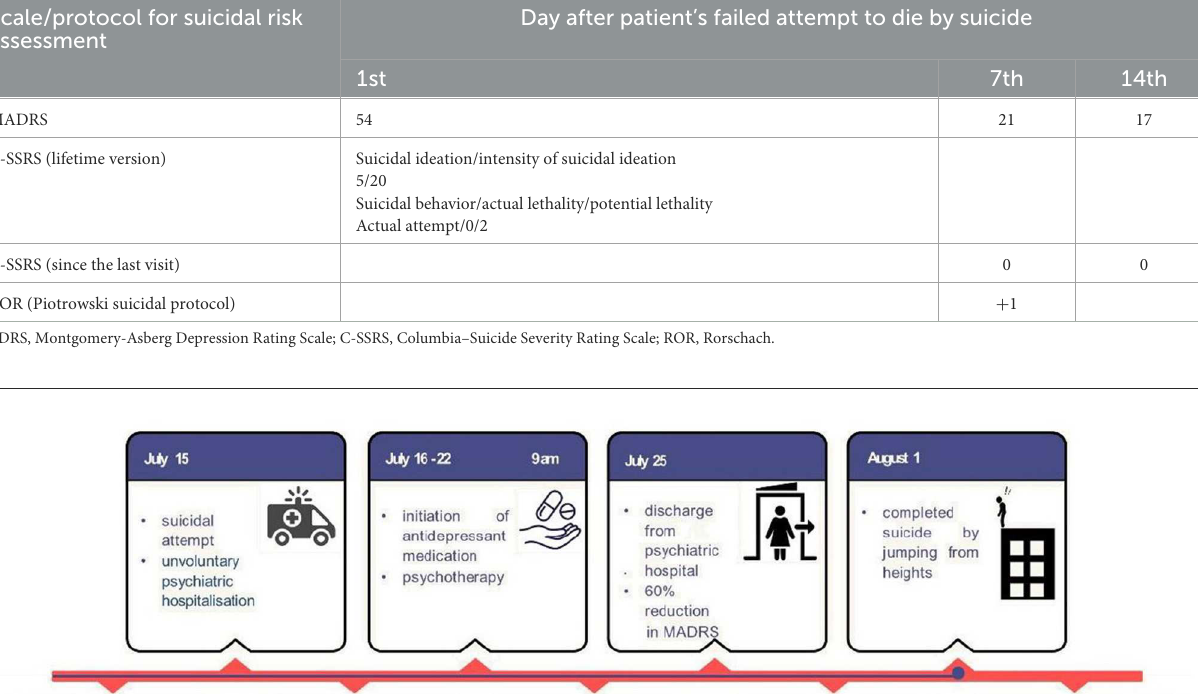
TABLE 1 An overview of the dynamics of the results (absolute values) of the used psychometric rating tools. Scale/protocol for suicidal risk assessment